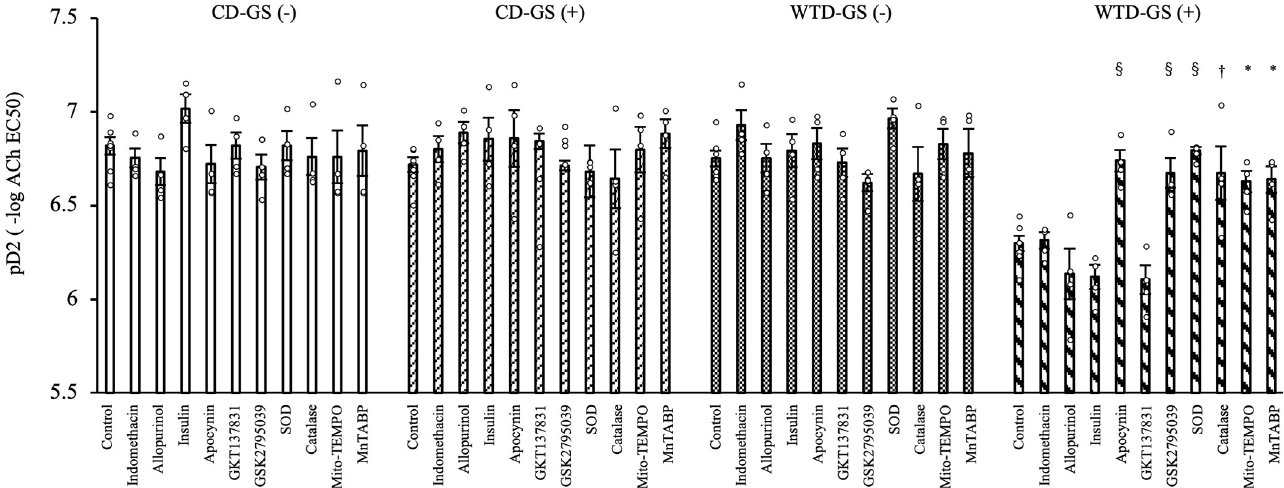
Fig 4. NOX inhibitors, SOD and catalase ameliorate endothelial dysfunction in the WTD-GS (+) group. Vascular sensitivity measured under 20 mM glucose conditions was plotted as pD2 (- log of the half-maximal effective concentration [EC50]) of ACh. The control was administered to 7 rats, and other agents were administered to 4 rats each. � P < 0.05, † P < 0.01, and § P < 0.001 compared with the control in the WTD-GS (+) group, Dunnett’s test. The data are presented as the means ± SEM. Indomethacin, a cyclooxygenase inhibitor; allopurinol, a xanthine oxidase inhibitor; apocynin, a NADPH oxidase (NOX) inhibitor; GKT137831, a NOX1 and 4 inhibitor; GSK2795039, a NOX2 inhibitor; SOD, superoxide dismutase; Mito-TEMPO, a mitochondria-targeted superoxide scavenger; MnTABP, a superoxide dismutase mimetic and peroxynitrite selective scavenger; CD, control diet; WTD, Western-type diet; GS, glucose spike.